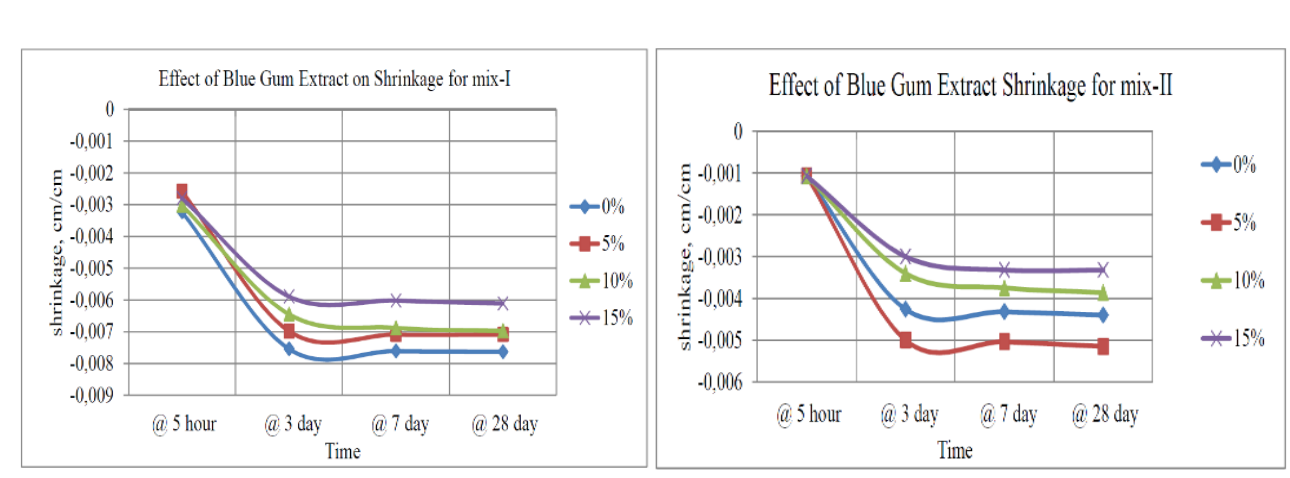
Figure 8. Test results from blue gram effecting on shrinkage (Woldemariam et al. [14]) Otunyo and Koate [15] evaluated concrete properties by replacing sugar cane juice (SCJ) with water in the following proportions: 0, 3, 5, 10, and 15%. The findings indicate that with the increasing percentage of SCJ in the concrete mix, the final setting time of concrete increased, at (15%) of SCJ added (2.5) hours to the setting time. Also, when SCJ content increased, the slump values decreased as at 0% SCJ replacement, the slump values of 60 mm were obtained, and at 15% SCJ replacement, the slump values were 10 mm. As a result, SCJ decreases the workability of concrete. Furthermore, compressive strength dropped as the SCJ amount increased to 10% SCJ replacement, then began to increase for 15% SCJ replacement.